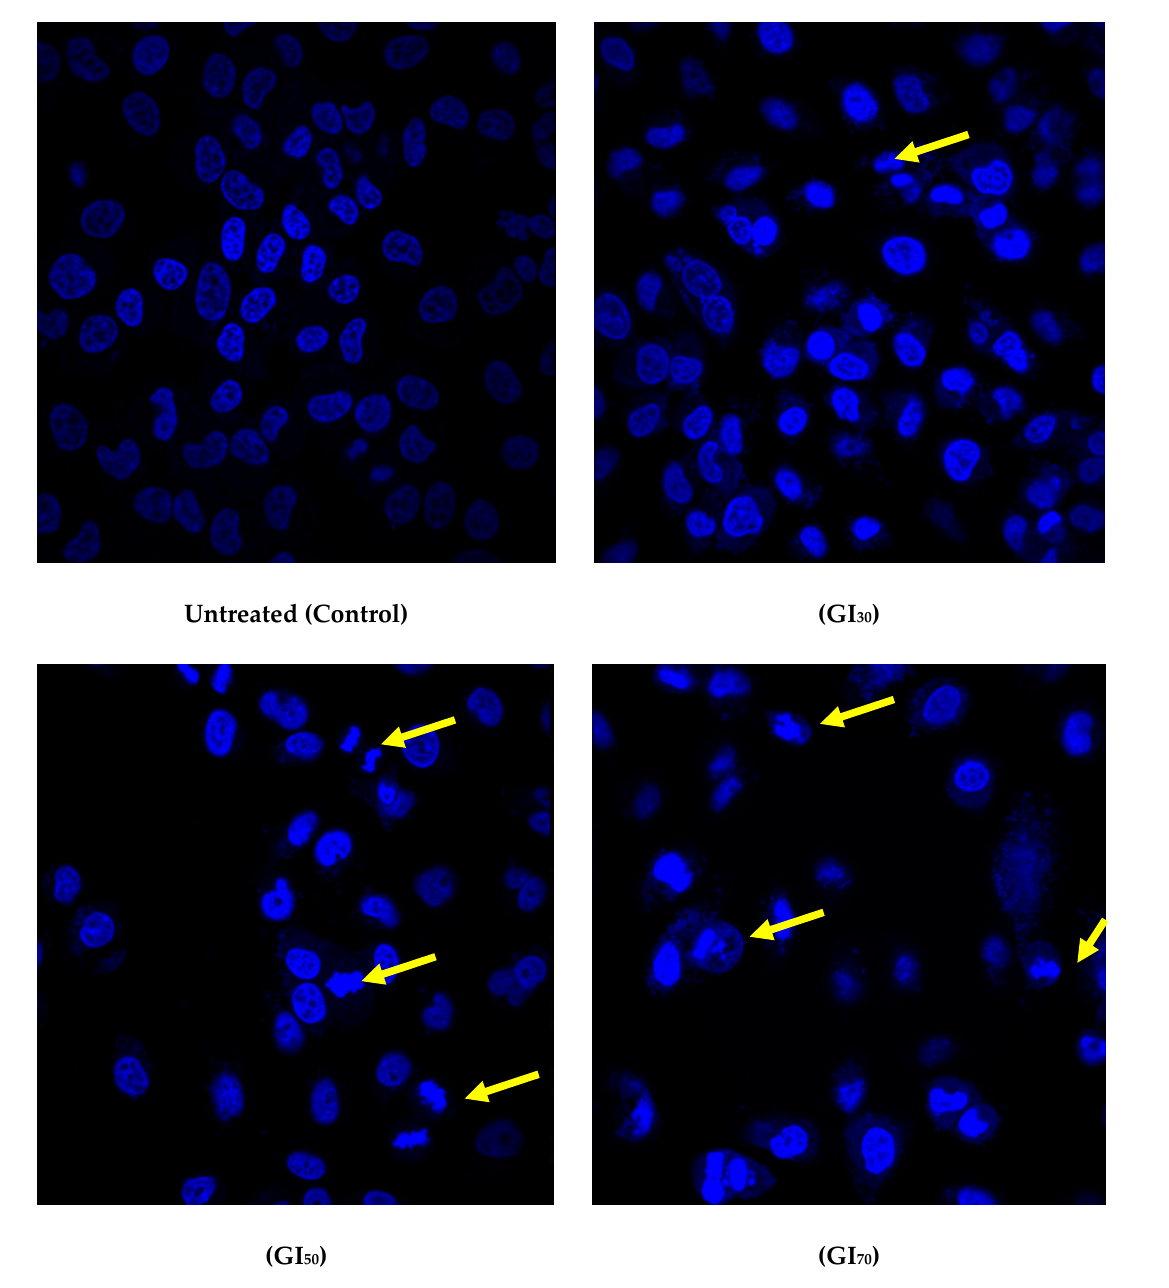
Figure 10. Confocal micrographs of Hoechst 33342 stained MG-63 cells treated with Epiafzelechin from C. fistula for 24 h. Arrows show nuclear condensation and formation of apoptotic bodies at a magnification 60× oil immersion objective lens.